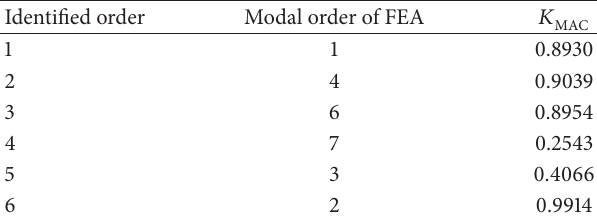
Table 10: Identified order and MAC value of modal shapes. Identified order